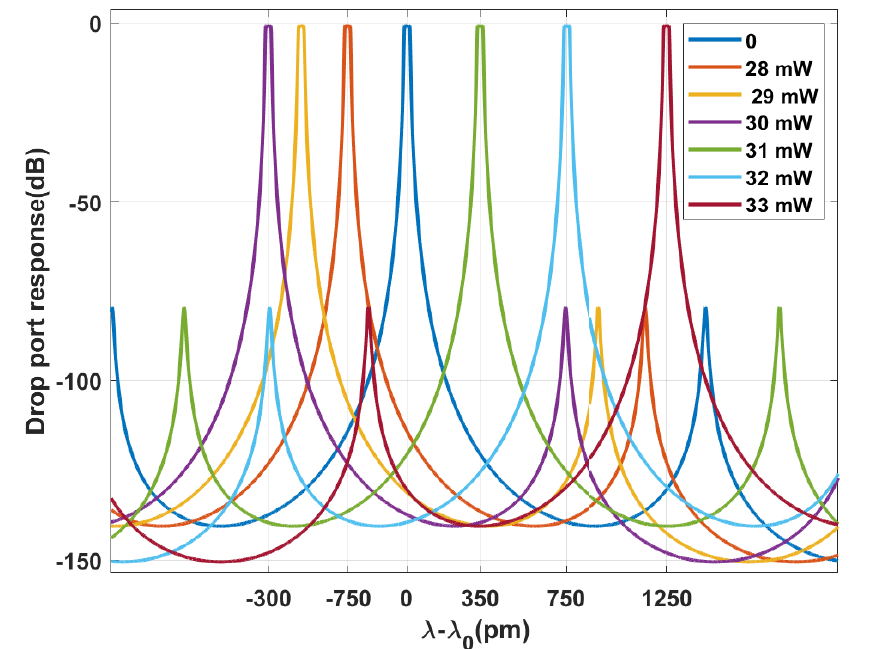
Figure 9. All-optically tuned Add-drop filter. The thickness and the scattering rate for the graphene layer are t G = 8 nm, Γ = 10 14 /s respectively. The resonance wavelength shifts from the original value of 1581.5 nm (blue curve) as a function of the injected power, varying from 28 to 33